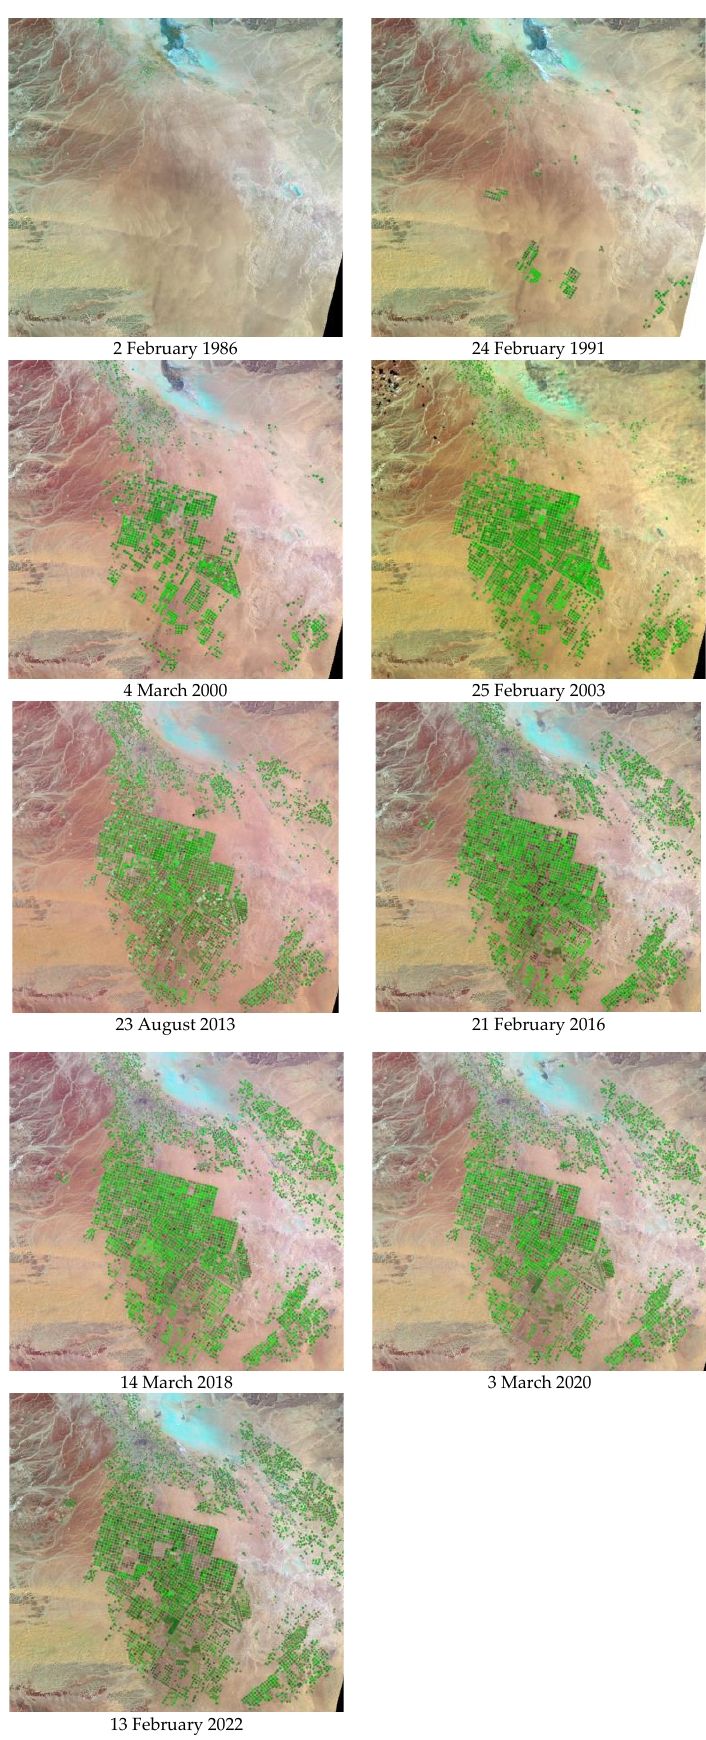
Figure 8. Images depicting the area’s land use and land cover from 1986 to 2022 [72].